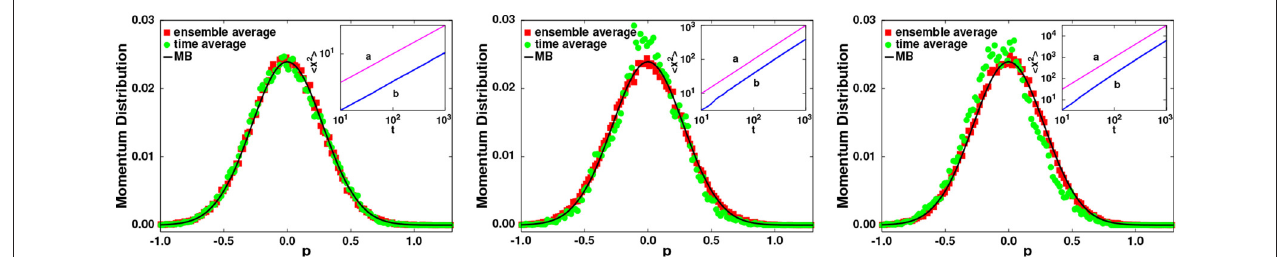
FIGURE 3 | (Color online) Numerical results for the probability distribution function for subdiffusion (left, α (right, α 1.5). The time averages (circles) are obtained by following one particle trajectory and calculating the histogram for times from t = ensemble averages (squares), we calculate the histogram using 5